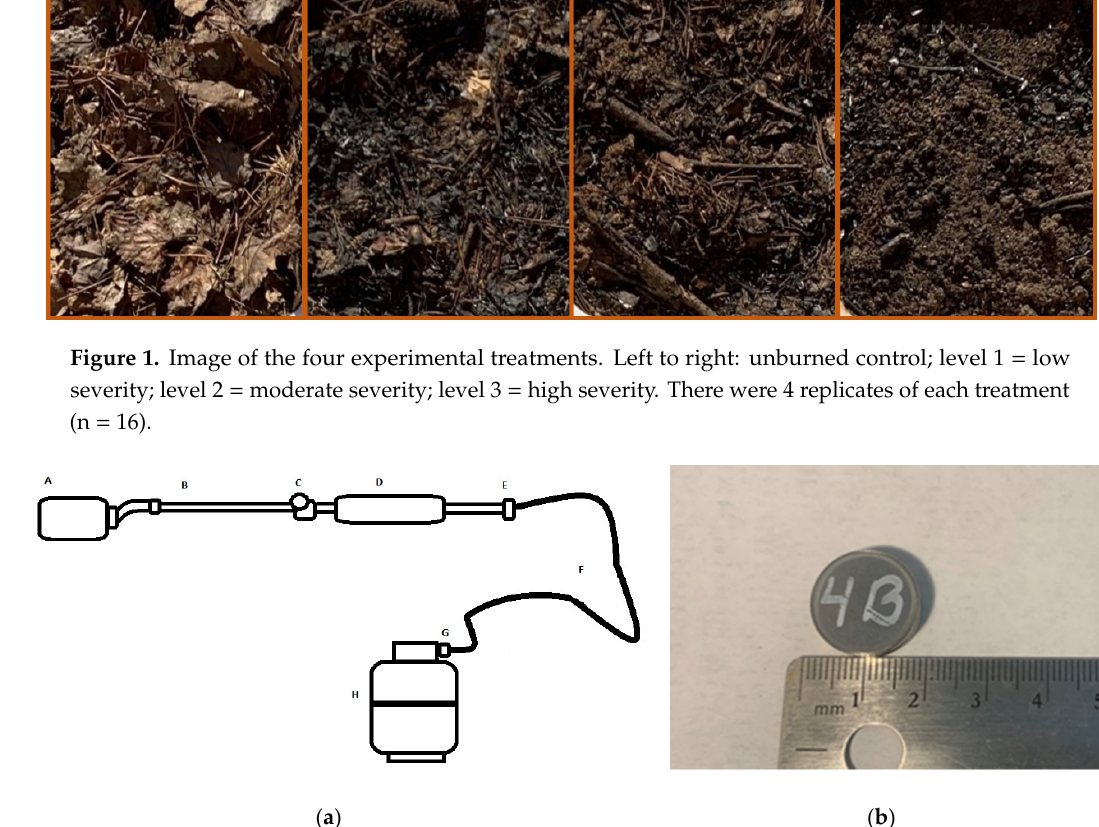
Figure 1. Image of the four experimental treatments. Left to right: unburned control; level 1 = low severity; level 2 = moderate severity; level 3 = high severity. There were 4 replicates of each treatment (n = 16).